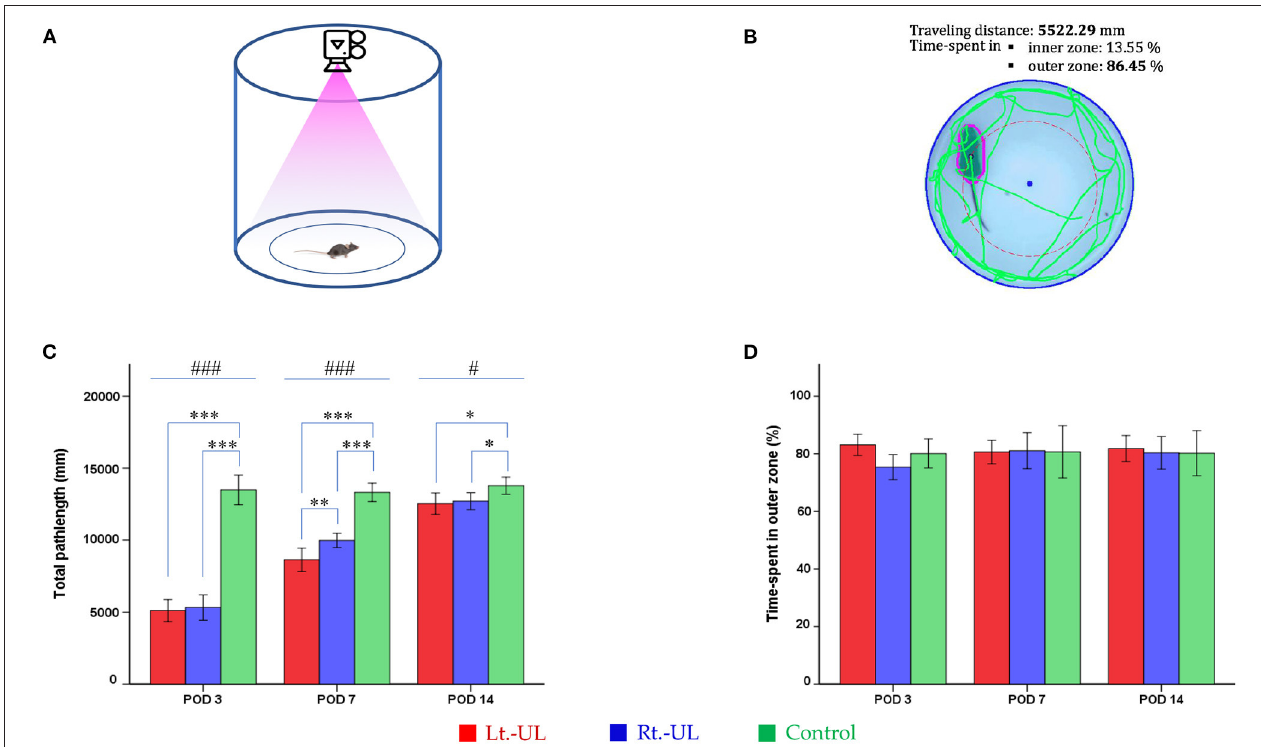
FIGURE 2 | Evaluation of the locomotor activities of mice using an open-field task. The open field apparatus with an overhead camera and lighting support system (A) . The recorded images were processed with the digital video-based tracking system (B) . The total path lengths of the Lt.- unilateral labyrinthectomy (UL) and Rt.-UL groups were decreased in comparison to the control group on postoperative days (PODs) 3, 7, and 14. On POD 7, the total path length of the Lt.-UL group was significantly less than that of the Rt.-UL group (C) . The percentage of time spent in the outer zone, which is an indicator of anxiety, did not differ between the three groups (D) . Values are indicated as mean ± SD. Statistical significances were calculated using one-way ANOVA with post-hoc tests. *Significantly different between two groups; #significantly different between three groups; *, # p < 0.05; ** p < 0.01; ***, ### p <